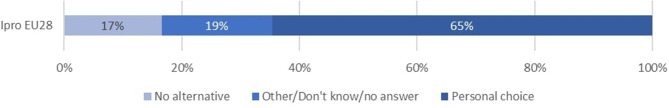
Choice for self-employed work.